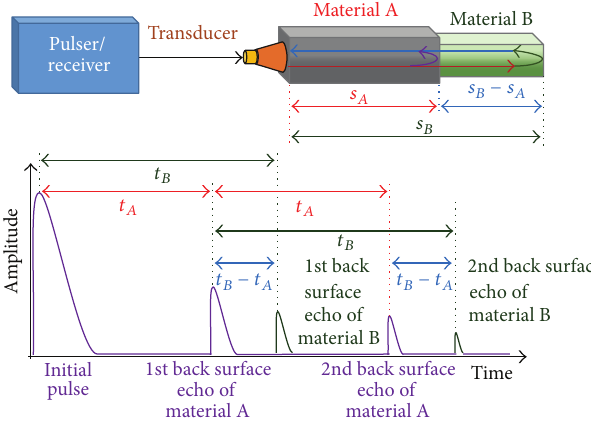
Figure 1: Pulse-echo ultrasonic method for two